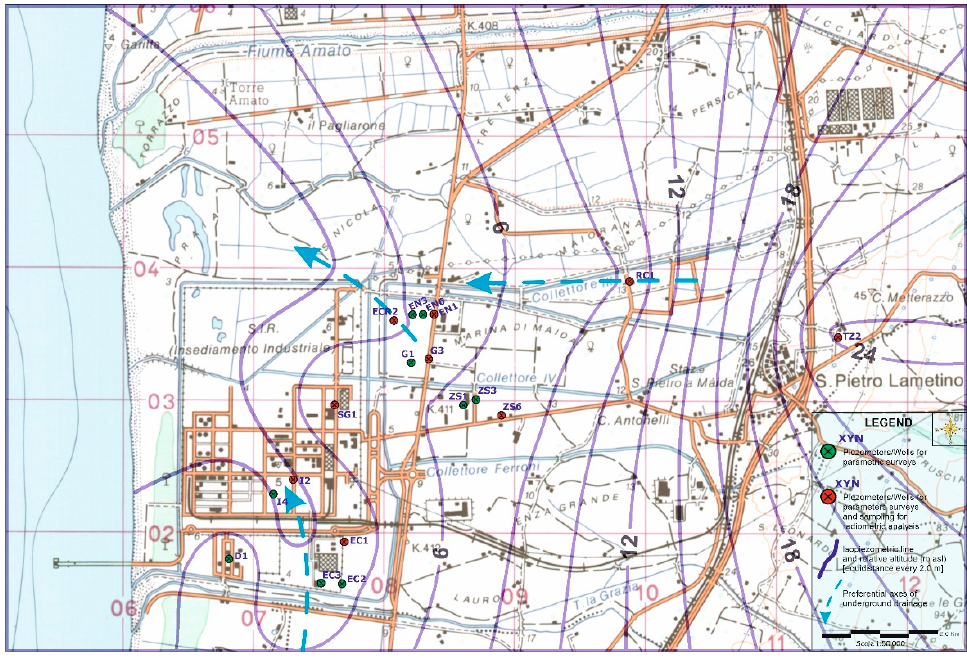
Figure 6. Isopiezometric Map of the Study Area, with the Locations of Monitoring Points (Modi- fied) [6].